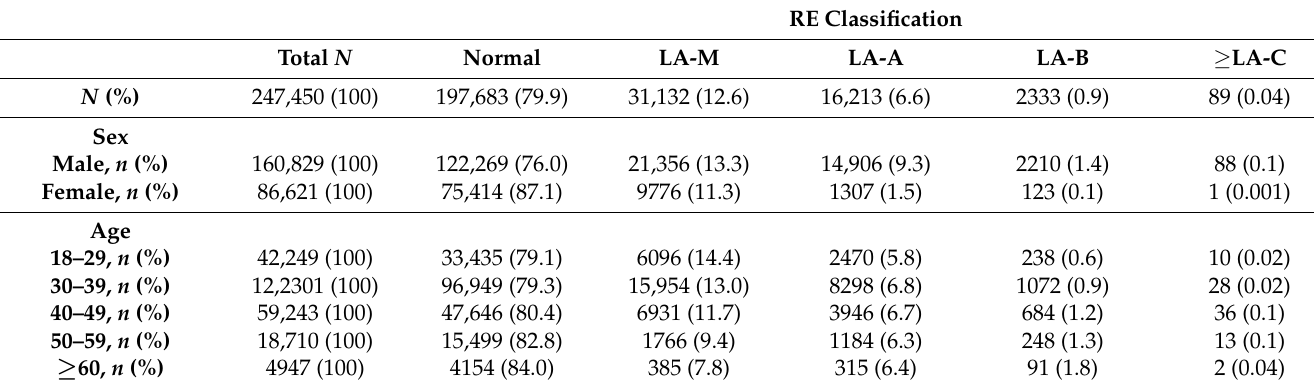
Table 2. The distribution of endoscopic findings of reflux